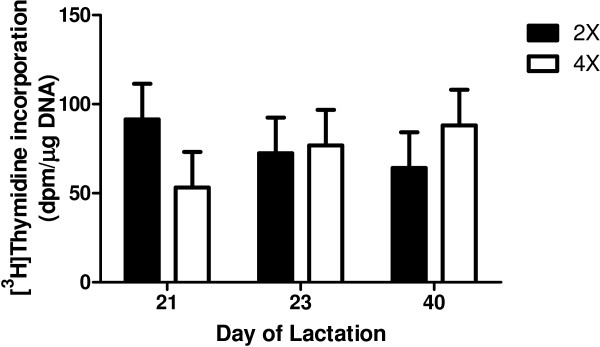
Incorporation of [3H]-thymidine into DNA of mammary tissue of cows (n = 6) assigned to unilateral frequent milking (UFM; twice daily milking (2×) of the left udder half, four times daily milking (4×) of the right udder half) for days 1 to 21 of lactation. Mammary biopsies from both udder halves were obtained on d 21, 23, and 40 of lactation. Each bar represents Least Squares mean ± pooled standard error. Incorporation of [3H]-thymidine into DNA was not affected by 4× milking or by day of lactation (P ≥ 0.80).